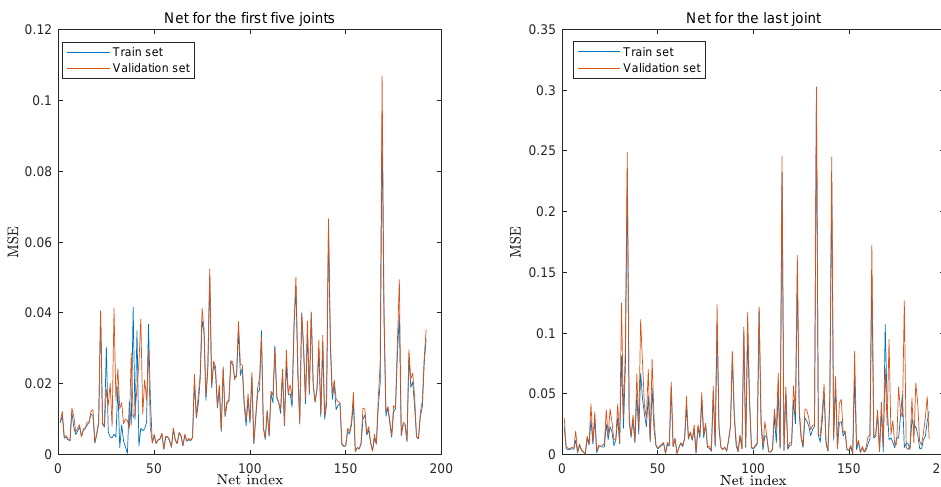
Figure 4. Final performance of the NNs for the prediction system.